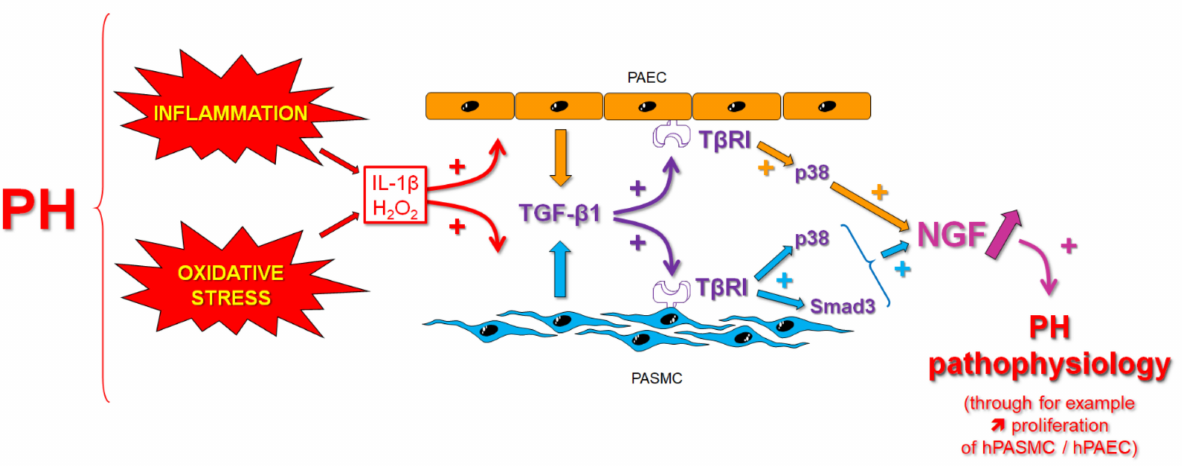
Figure 9. Potential mechanisms of TGF- β 1-induced NGF pulmonary arterial secretion in pulmonary hypertension. Inflammation and oxidative stress are pathological conditions in pulmonary hyperten- sion (PH). Increased production of pro-inflammatory cytokines such as interleukin-1 β (IL-1 β ) or of reactive oxygen species such as hydrogen peroxide (H 2 O 2 ) can stimulate pulmonary arterial cells such as pulmonary arterial smooth muscle (PASMC) or endothelial cells (PAEC) to secrete transforming growth factor- β 1 (TGF- β 1). This factor then acts in an autocrine fashion on the same cells through activation of its T β RI receptor and of Smad3 and/or p38-dependent signaling pathways to induce the secretion of nerve growth factor (NGF). This mechanism may contribute to NGF increased pulmonary arterial secretion observed in PH. Since TGF- β 1 also plays a pathological role in this disease, such mechanisms of TGF- β 1-dependent increase in NGF pulmonary arterial secretion may be relevant to human PH